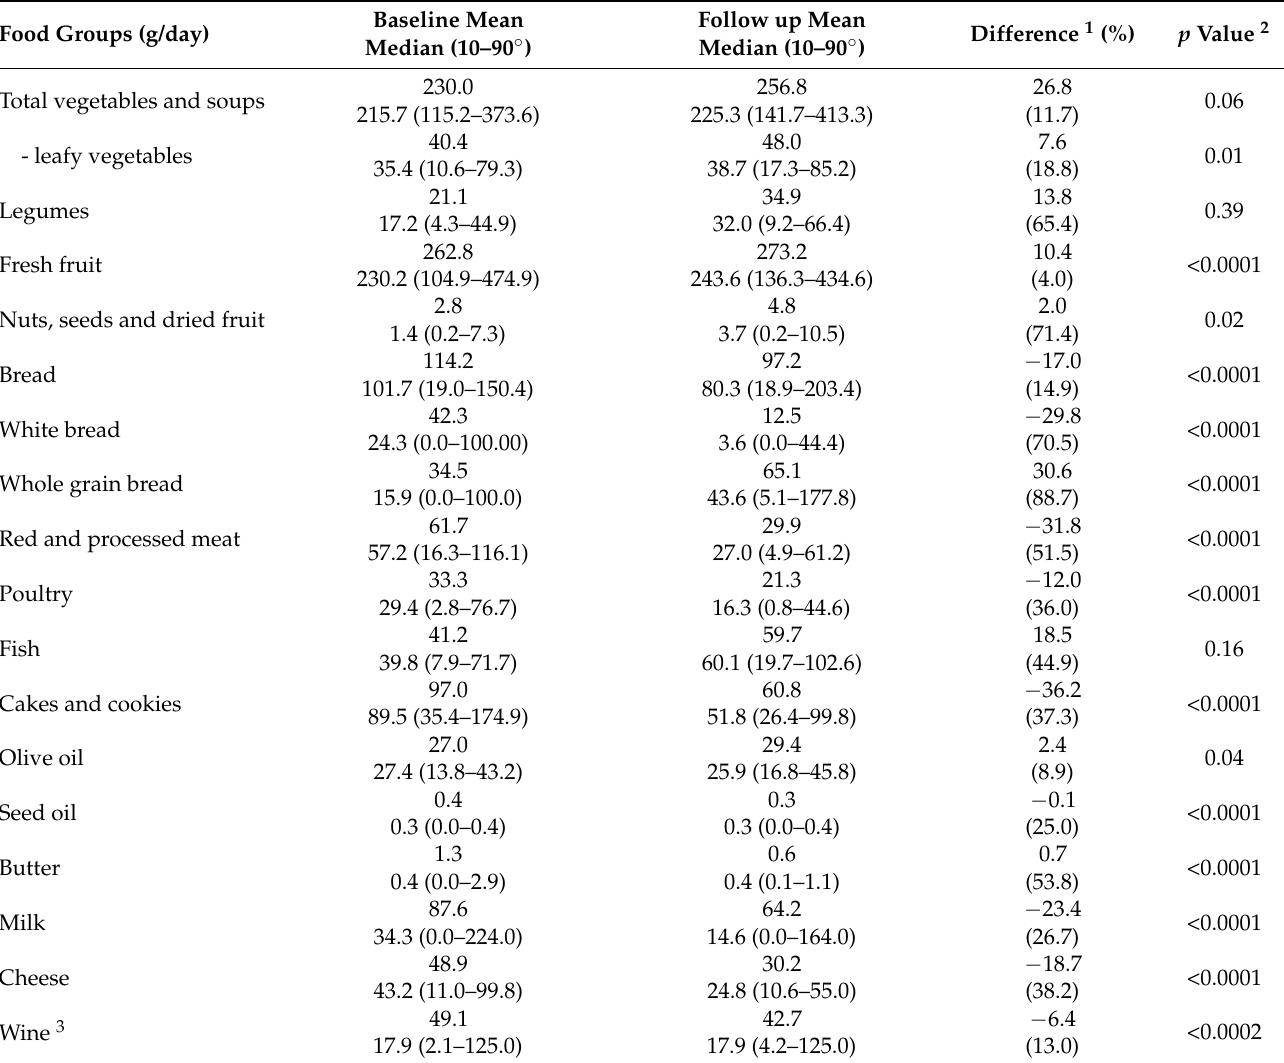
Table 4. Estimated changes in consumption of selected food (g/day) and kilocalories at the end of the intervention in comparison to baseline. (The DAMA25 study, Florence, Italy,